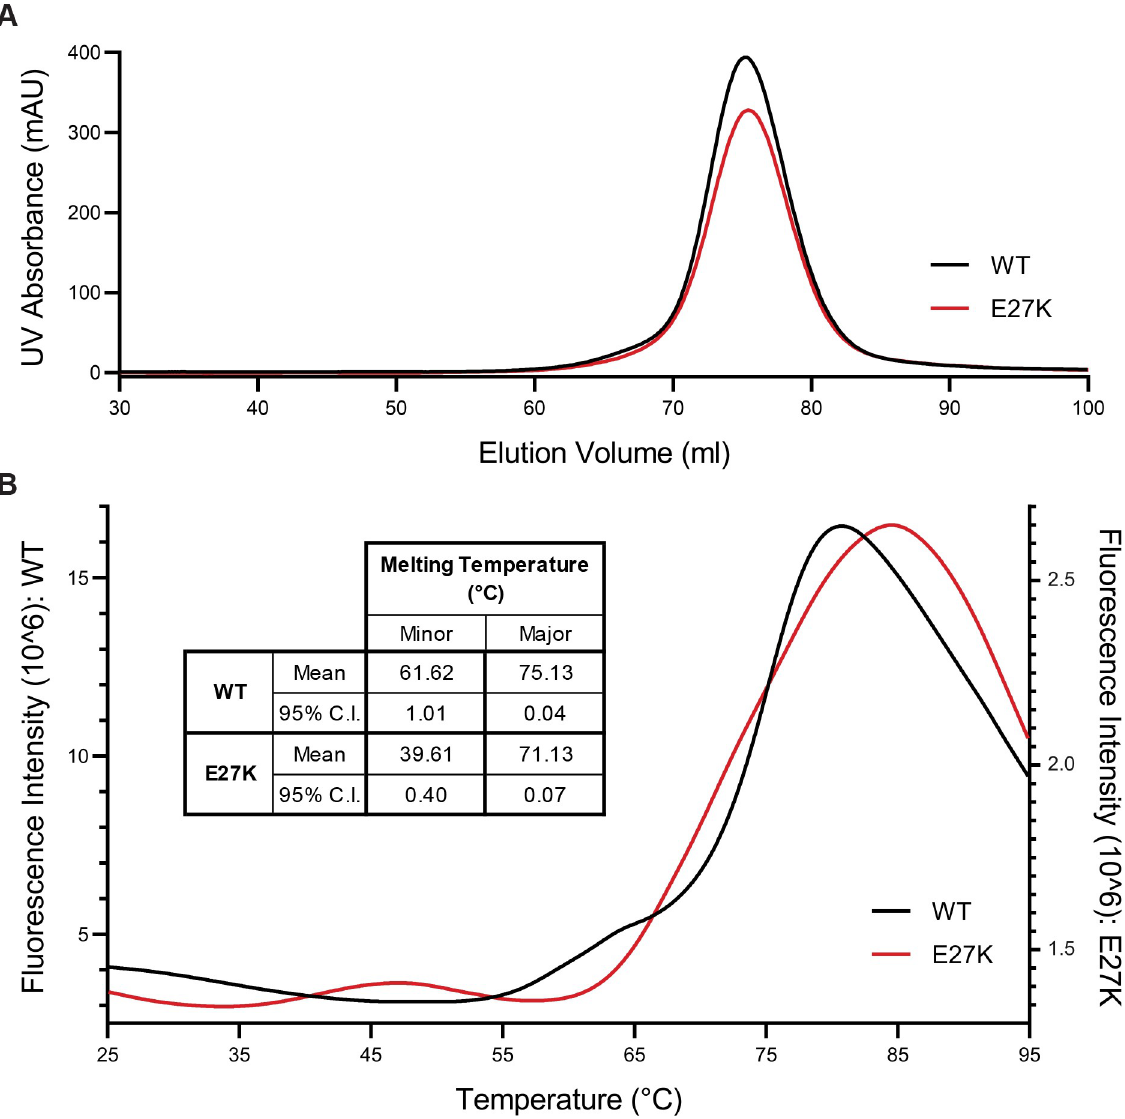
Fig 5. Purified p.E27K SSBP1 is a stable tetramer but is slightly less thermostable than WT SSBP1. A. UV intensity measurements are plotted against elution volume for size exclusion chromatography of WT SSBP1 and p.E27K SSBP1. B. Representative thermal denaturation curves for WT SSBP1 and p.E27K SSBP1 are overlaid. Inset table lists average melting temperatures for minor (leftmost) and major (rightmost) melting peaks for each protein (n = 3). Differences between values for WT and p.E27K at minor and major melting peaks are statistically significant (minor, p = 0.0001; major, p <